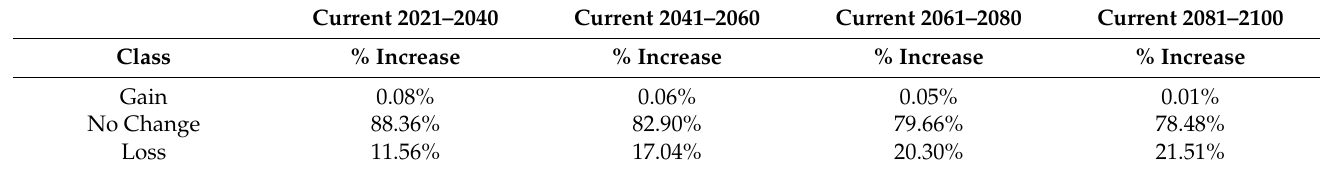
Table 5. Percentage of distributional changes of 16SrII-D between current and future climate-change scenarios.